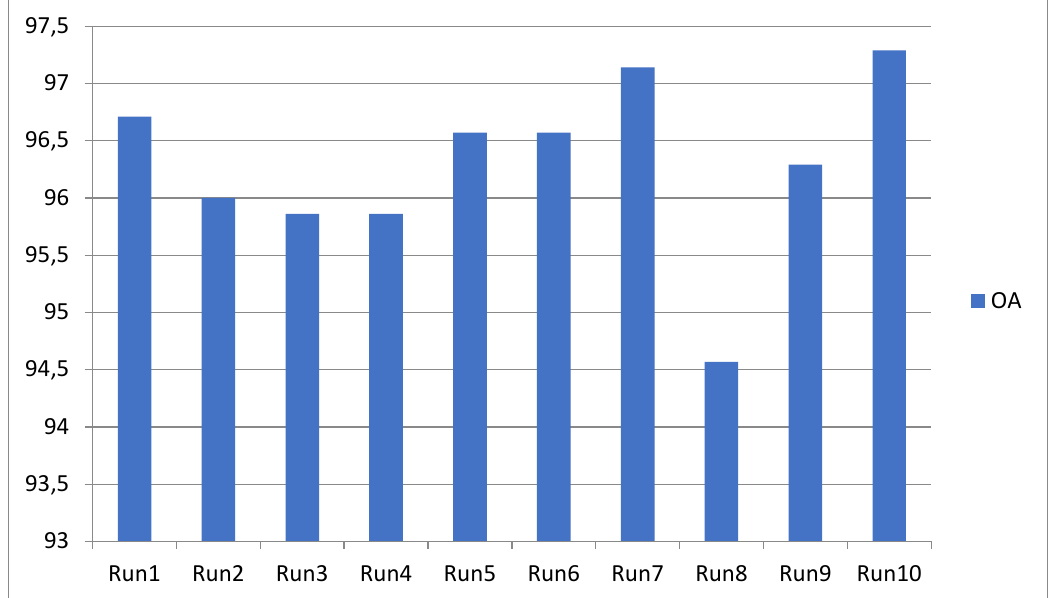
Figure 11. Overall accuracy comparison